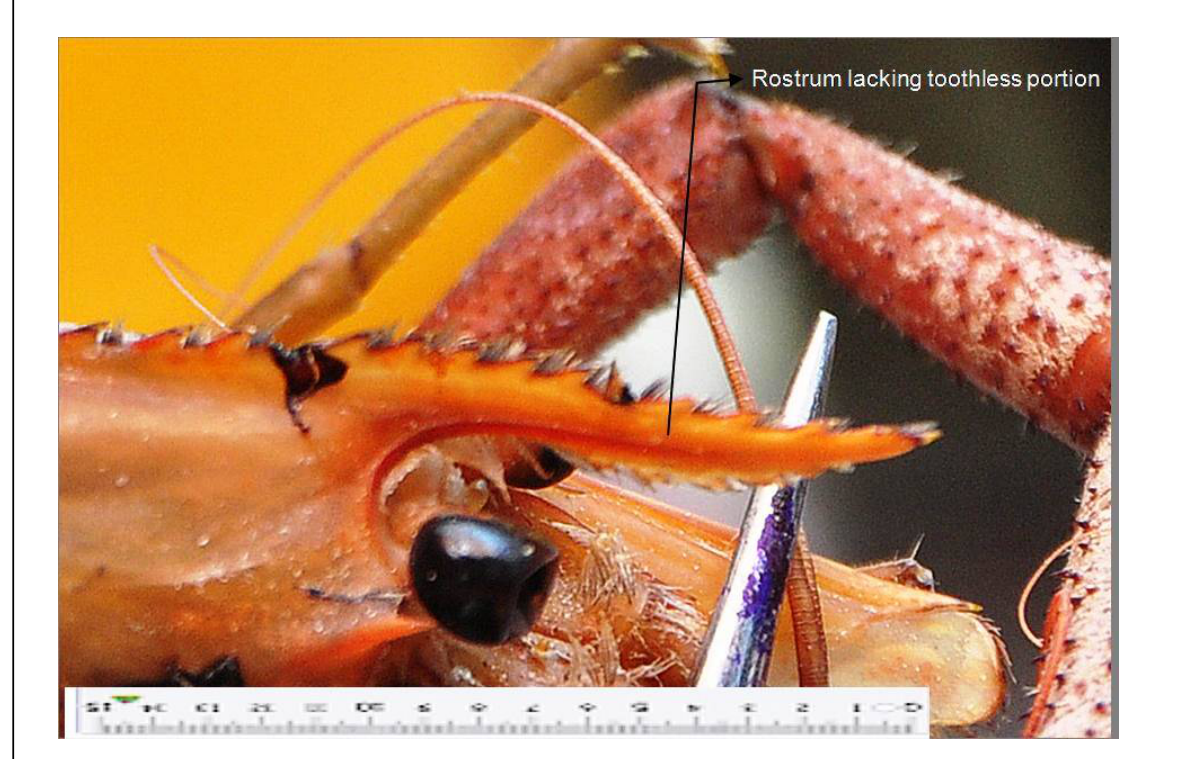
lacking toothless portion – Magnification: X3